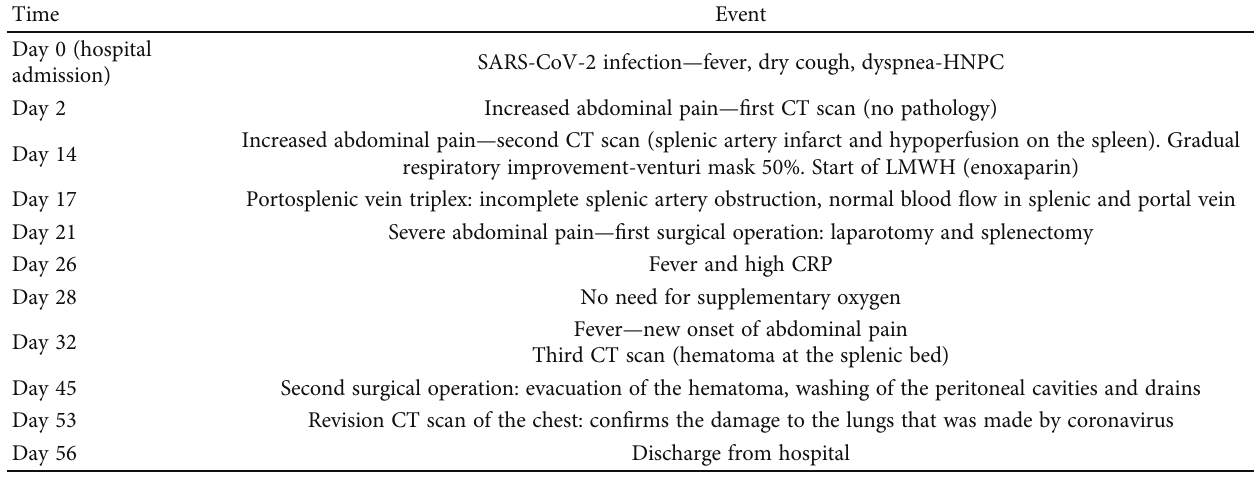
Table 1: Timeline of clinical sequelae of the